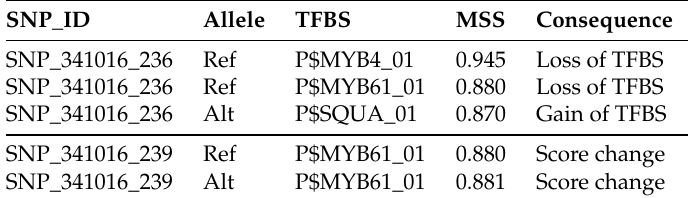
Table 5. The two SNPs with the strongest association to the V+C content and their consequences. The column Allele indicates for which allele of the SNP the binding site was found. TFBS refers to the name of the binding sites, which were named after their PWMs. The structure of the PWM names is given as: P$TFname_version, where “P$” stands for the PWMs used for the prediction of the TFBSs of plant TFs. “TFname” refers to the name of the transcription factor, and “_version” refers to the version of the